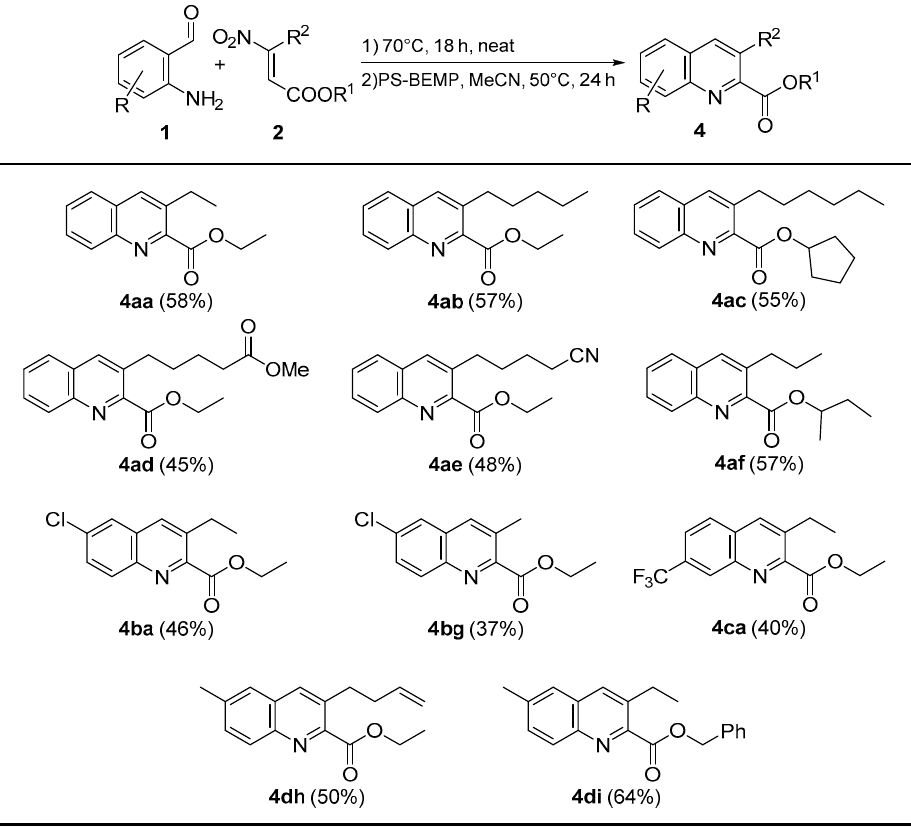
Scheme 5. One-pot reaction